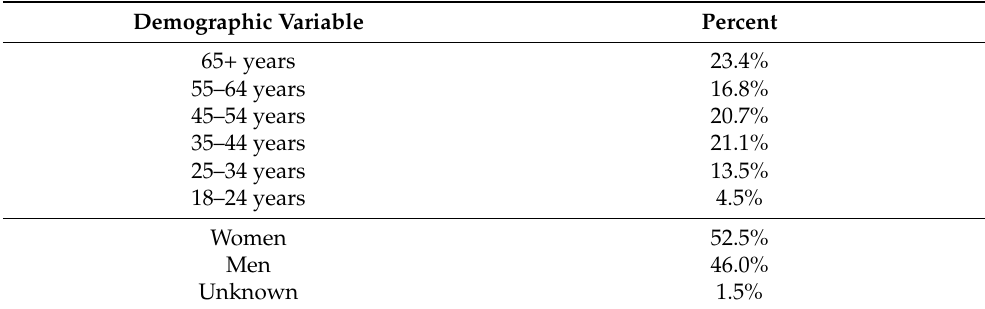
Table 1. Percent Distribution of Facebook and Instagram Link Clicks by Gender and Age During the